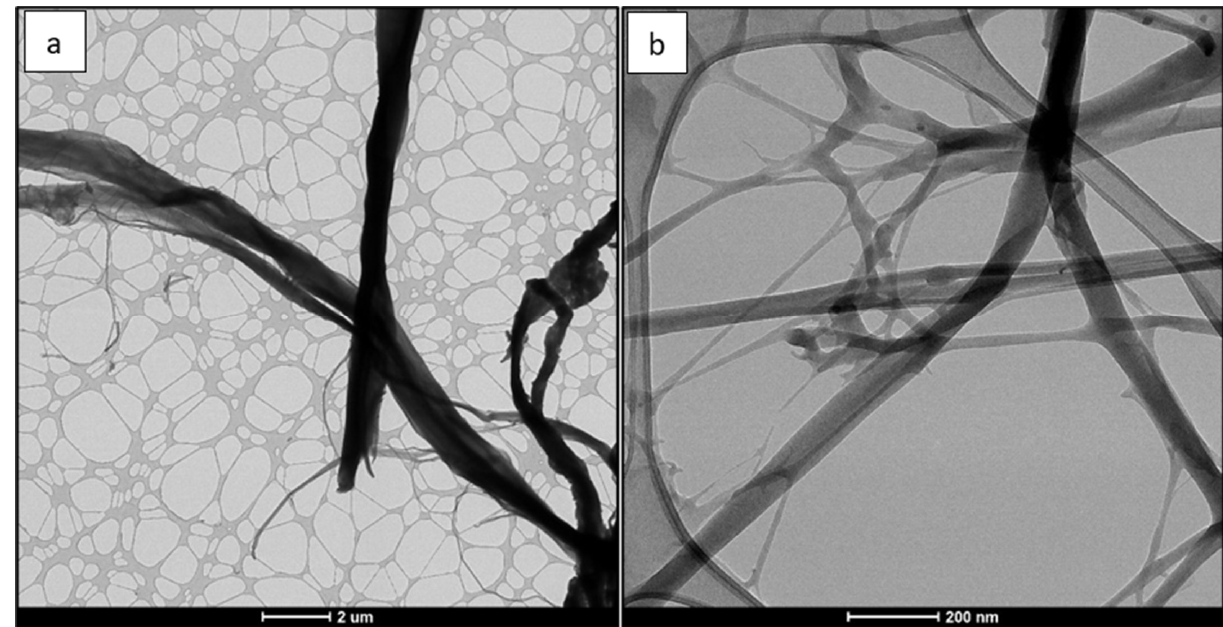
Figure 3. TEM images of CNF at two magnifications whose scale are: ( a ) 2 µm and ( b ) 200 nm.